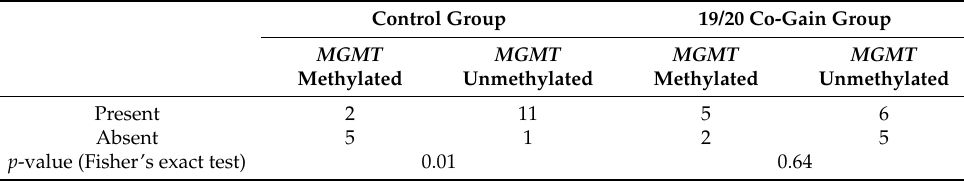
Figure 2. Sample imaging features of glioblastoma without 19/20 co-gain. FLAIR image of MGMT methylated tumor located in the left temporal lobe ( A , asterisk). T2 images of MGMT unmethylated tumor located in the right frontal lobe ( B , asterisk). T1 postcontrast image of MGMT unmethylated tumor located in the right temporal lobe demonstrating ependymal extension ( C , arrow). T1 postcontrast image of MGMT unmethylated tumor located in the right parietal lobe demonstrating pial invasion posteriorly ( D , arrow). Table 5. Ependymal extension.